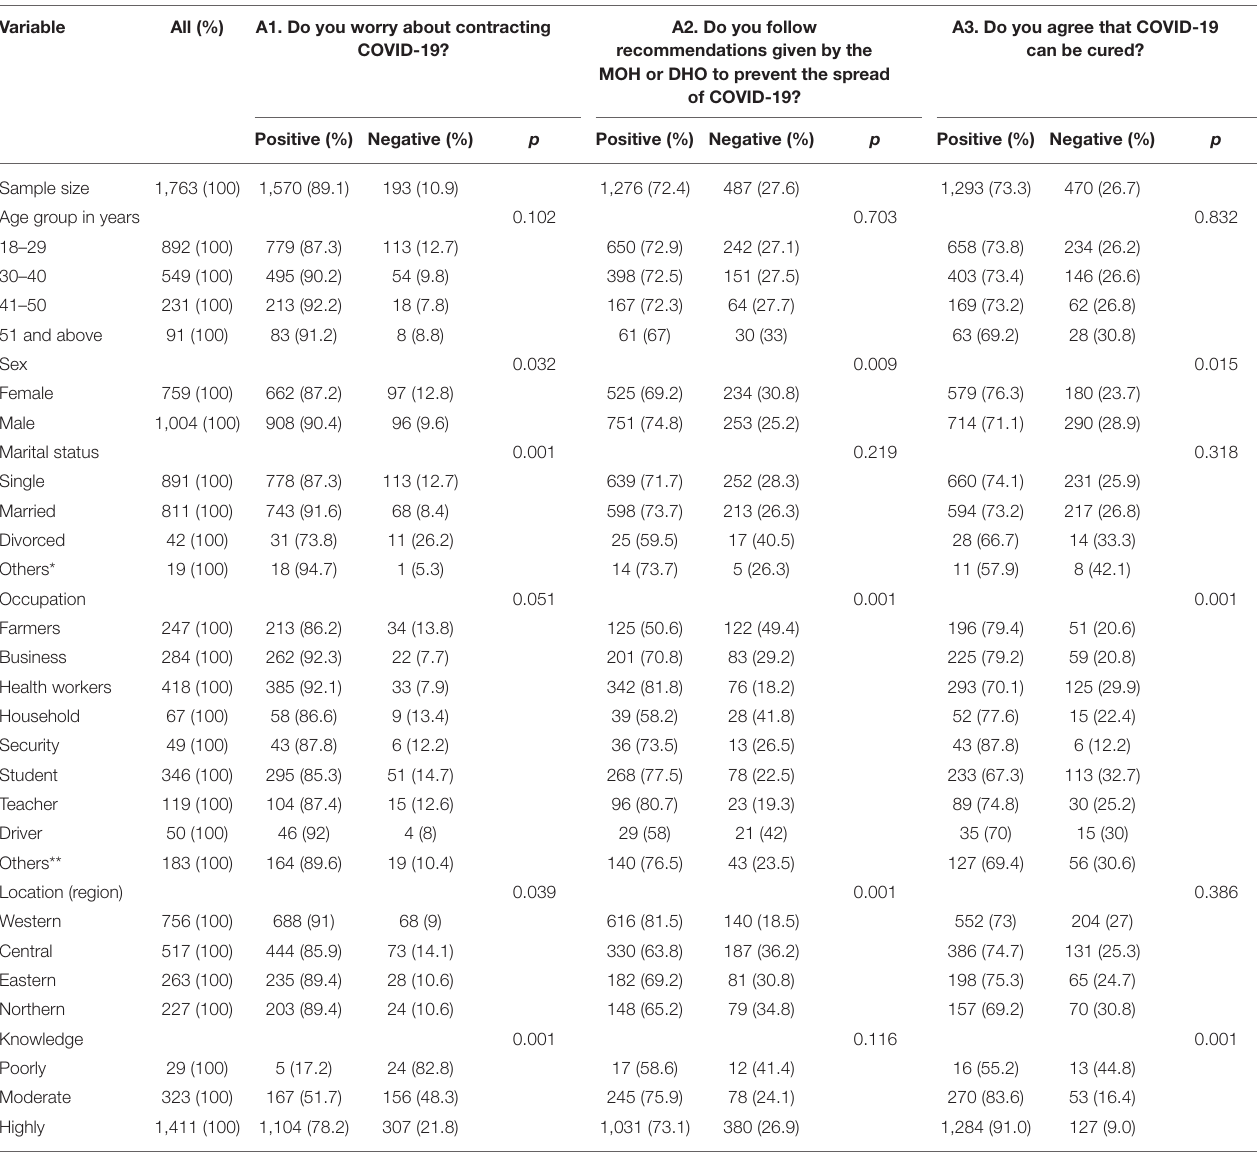
TABLE 3 | Association of attitude with socio-demographic characteristics of participants.